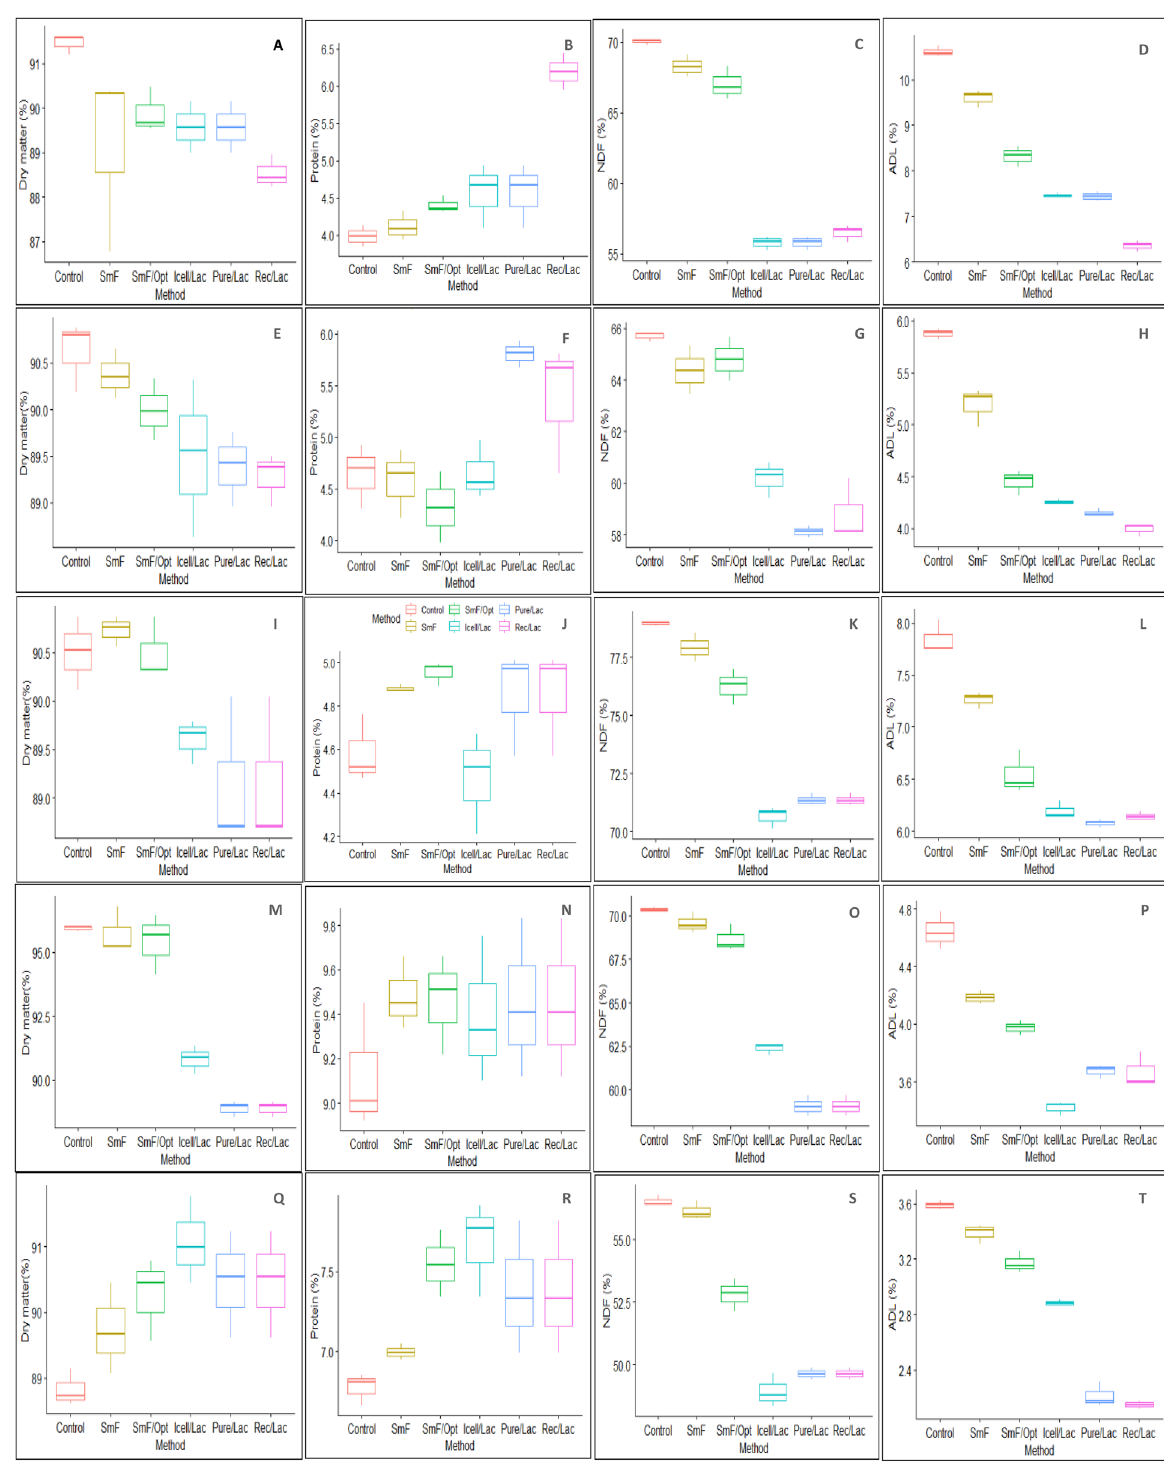
Figure 2. Box and whisker plots showing the distribution of proximate composition of five different crop residues after treatment using laccase enzyme: ( A – D ) finger millet (FMS); ( E – H ) paddy (PS); ( I – L ) wheat (WS); ( M – P ) maize (MS) and ( Q – T ) sorghum (SS). Labels ( A , E , I , M , Q ) represents dry matter (DM)%, ( B , F , J , N , R ) represents Protein %, ( C , G , K , O , S ) represents Neutral Detergent Fiber (NDF)%, ( D , H , L , P , T ) represents Acid Detergent Lignin (ADL)% of FMS, PS, WS, MS and SS respectively. The representative color codes for each production method are as follows Control (pink); laccase from Submerged fermentation, SmF (amber); laccase produced using optimized media in submerged fermentation, SmF/Opt(green); laccase obtained from immobilized cells, Icell/Lac (cyan); purified laccase, Pure/Lac (sky blue) and recombinant laccase, Rec/Lac (Magenta). Bars represent the standard error of means from three